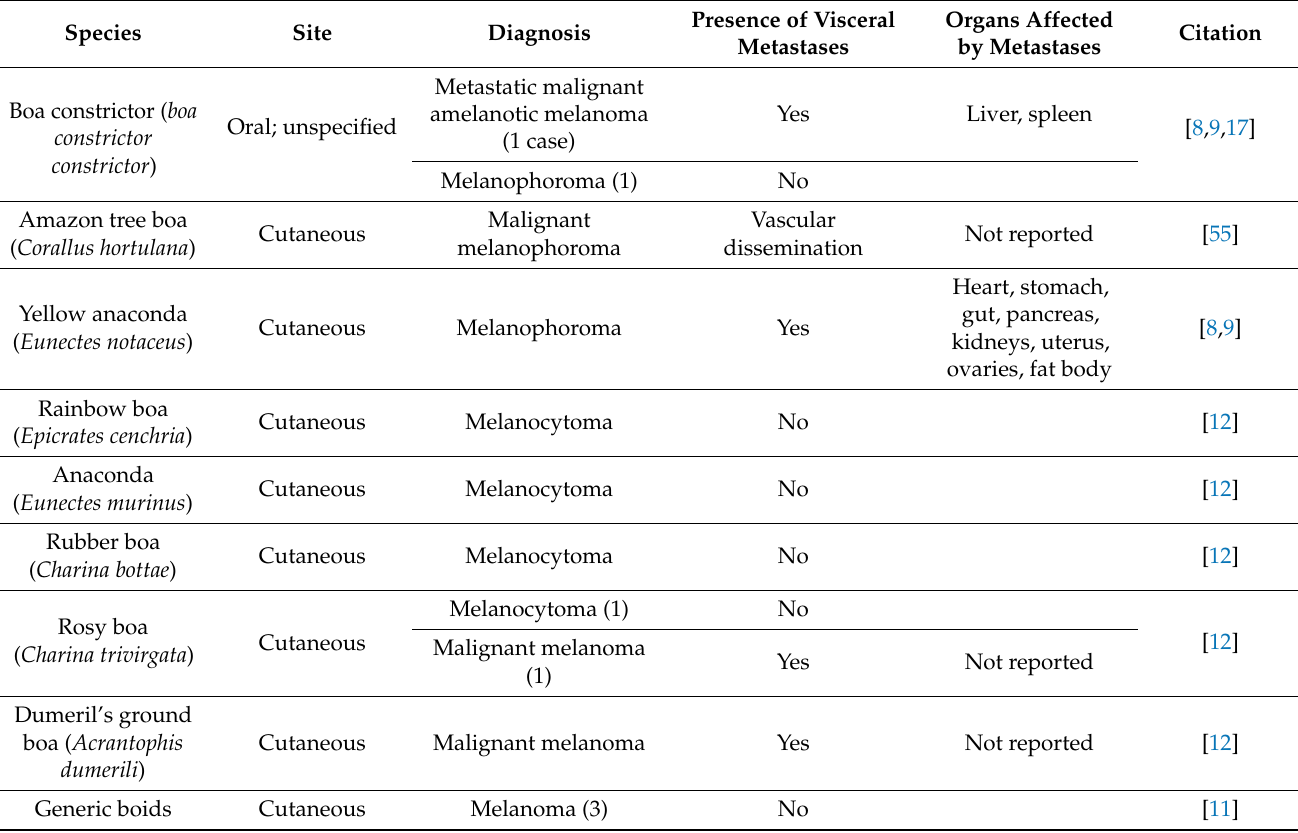
Table 10. Clinical features of chromatophoromas in the reptile family: Boidae .